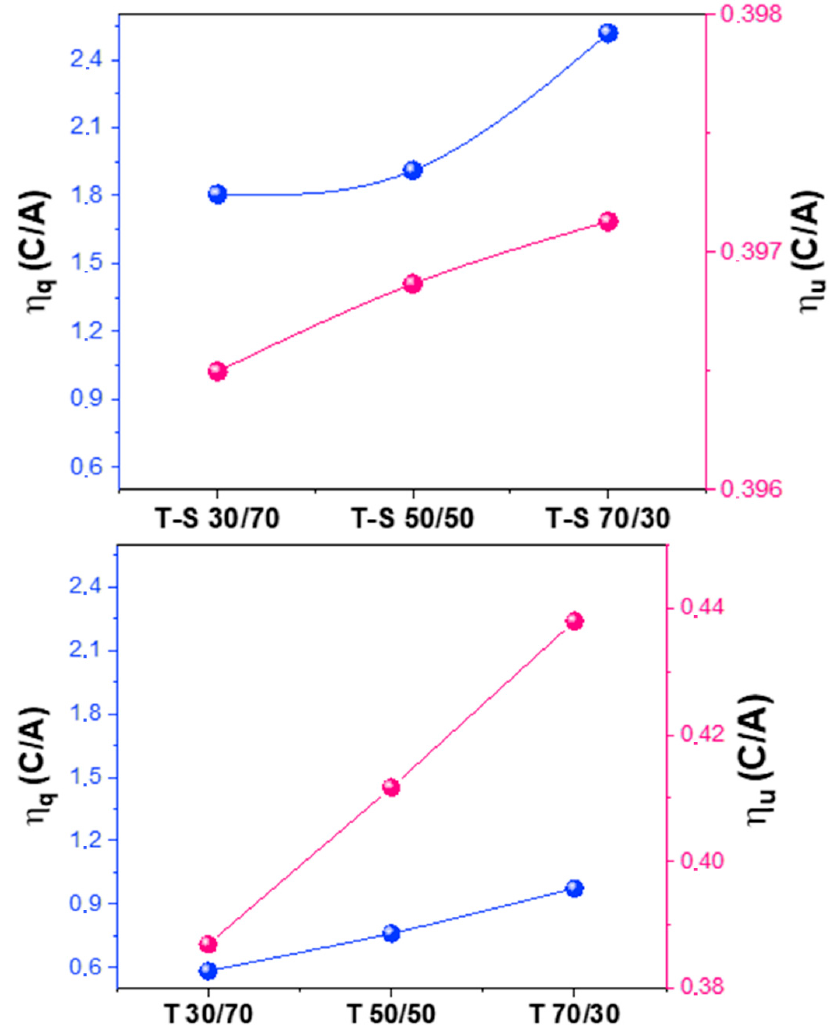
Figure 10. Ratio of efficiency observables (quantum efficiency, η q , and photon usage, η u ) between the contribution of carbon-centered (C in the figure) and alkoxy (A in the figure)-derived reaction products. T and T-S samples are presented (see OX axis labels).